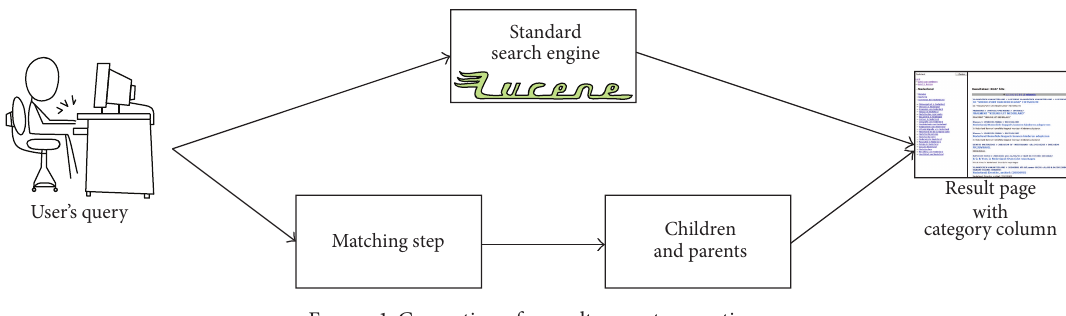
Figure 1: Generation of a result page at query time.